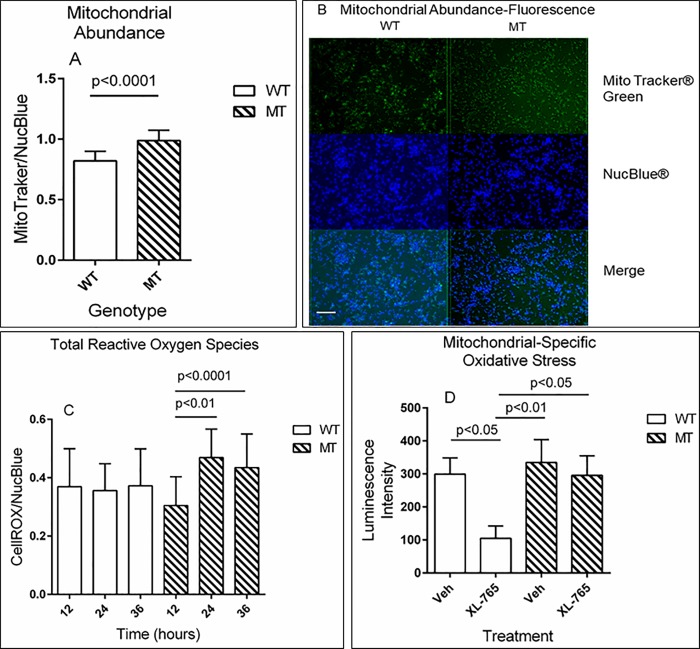
Mitochondrial abundance and oxidative stress parameters in NSCs.MitotrackerTM fluorescent staining was employed to assess mitochondrial abundance.Quantitation of fluorescent microscopy images in which MitoTracker signal (green) was normalized to nuclear stain (blue, NucBlue) (A) and representative fluorescence images employed for data accrual (B; scale bar = 50 μm (white)). CellROXTM staining was used to assess overall degree of oxidative stress (total reactive oxygen species), and different durations of treatment with starvation media (12–36 hours) (C). Mitochondrial specific oxidative stress was determined with a luminescence assay (MitoSoxTM system), in the presence and absence of 10 nM XL-765 (normalized to cell viability) (D). All values represent the mean of 3 replicates with error bars denoting SD. Data for Fig 4A assessed using a two-tailed t test. For Fig 4C, a one-way ANOVA with post-hoc analysis was used within genotype (wild-type, (F (2, 51) = 12.5; p = ns: mutant, F (2, 51) = 12.5; p<0.0001) and for Fig 4D across genotypes (F (3, 8) = 10.72, p<0.01). Abbreviations employed were as described in Fig 3.